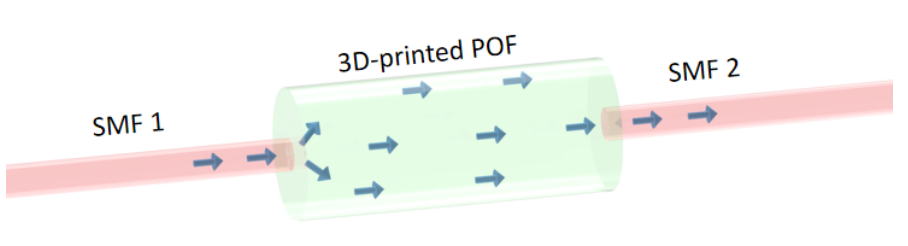
Figure 2. Fibers’ mode propagation